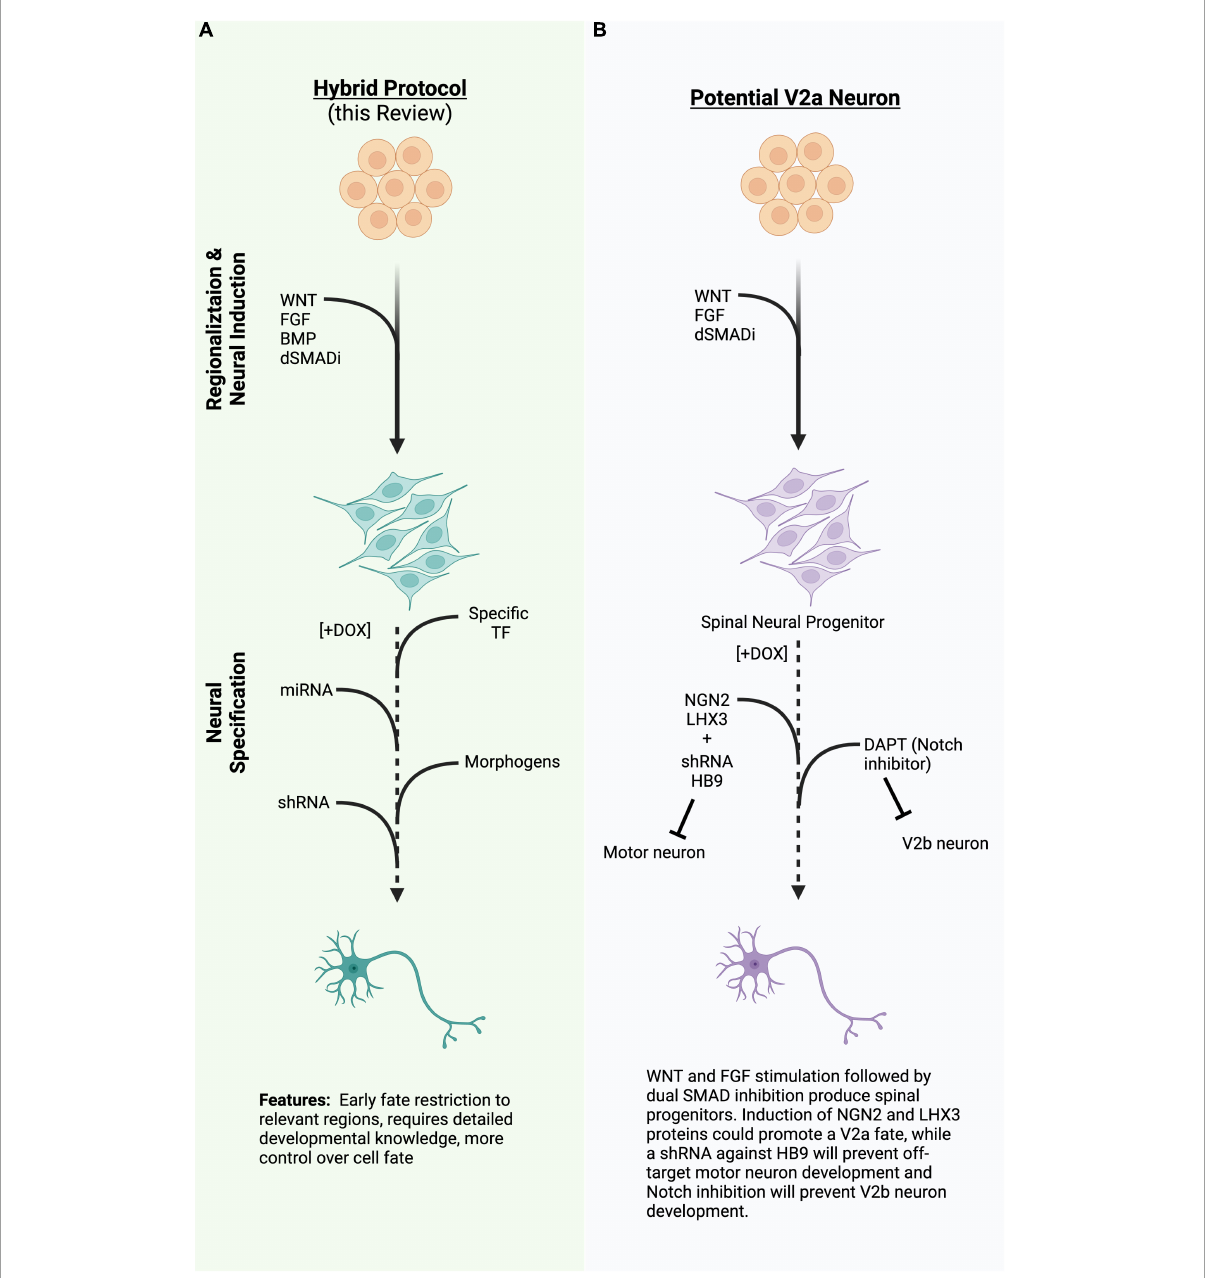
FIGURE2 (A) A diagram of a hybrid differentiation paradigm employing the same regionalizing steps as directed differentiation while inducing specific transcription factors (TFs), miRNA, or shRNA to quickly induce or refine cell type during neural specification. (B) An example of a potential way to generate V2a neurons using the hybrid approach in 2A. TFs, transcription factors; miRNA, micro ribonucleic acid; shRNA, short hairpin ribonucleic acid; (Created with